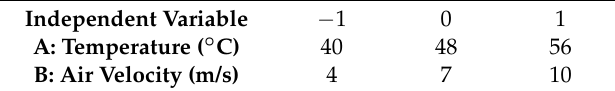
Table 1. Optimisation parameters, experimental range and level of independent variables.